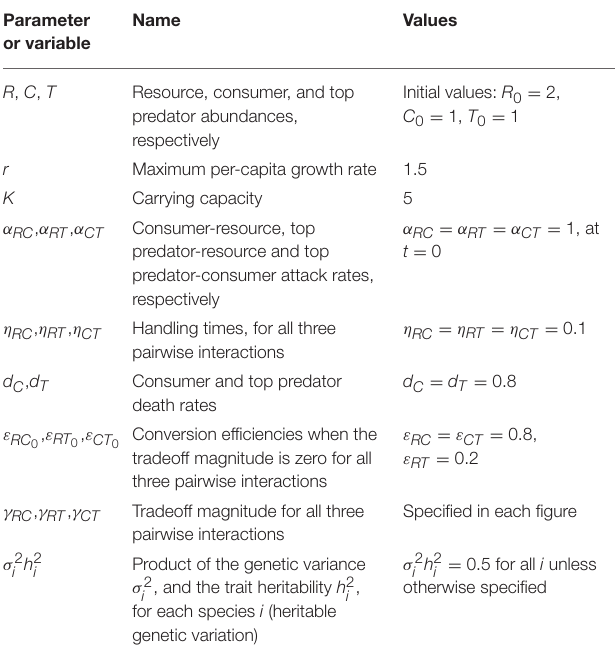
TABLE 1 | Model parameters and variables descriptions and values. Parameter or